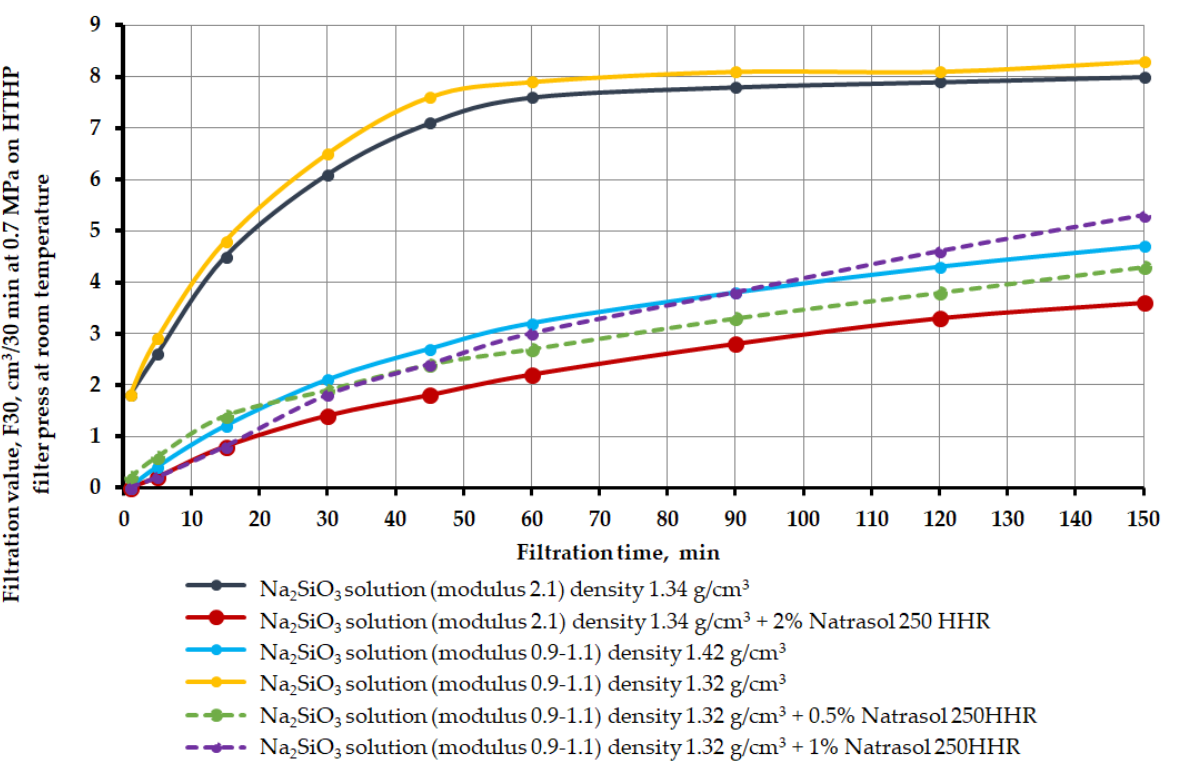
Figure 6. Filtration change over time in brine crosslinkers as a function of silicate modulus, density, and hydroxyethyl cellulose content Natrosol 250HHR.